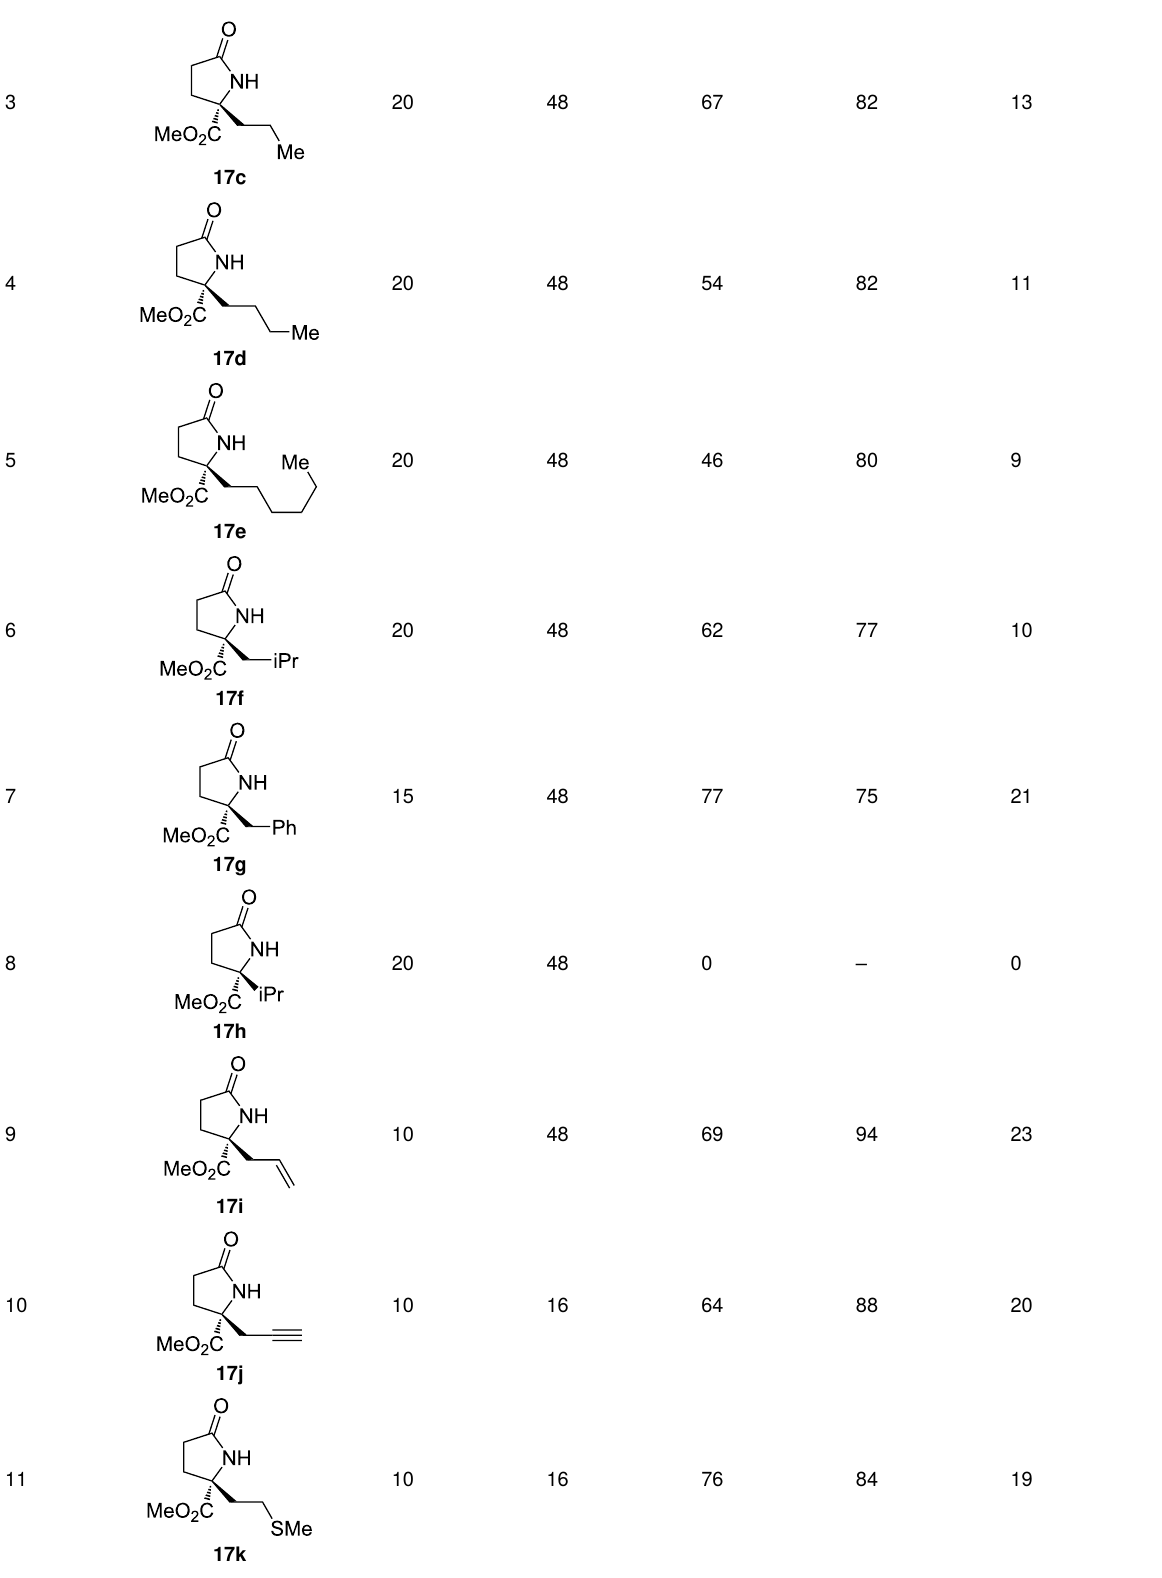
Table 2: Substrate scope of amino ester imine additions to methyl acrylate.